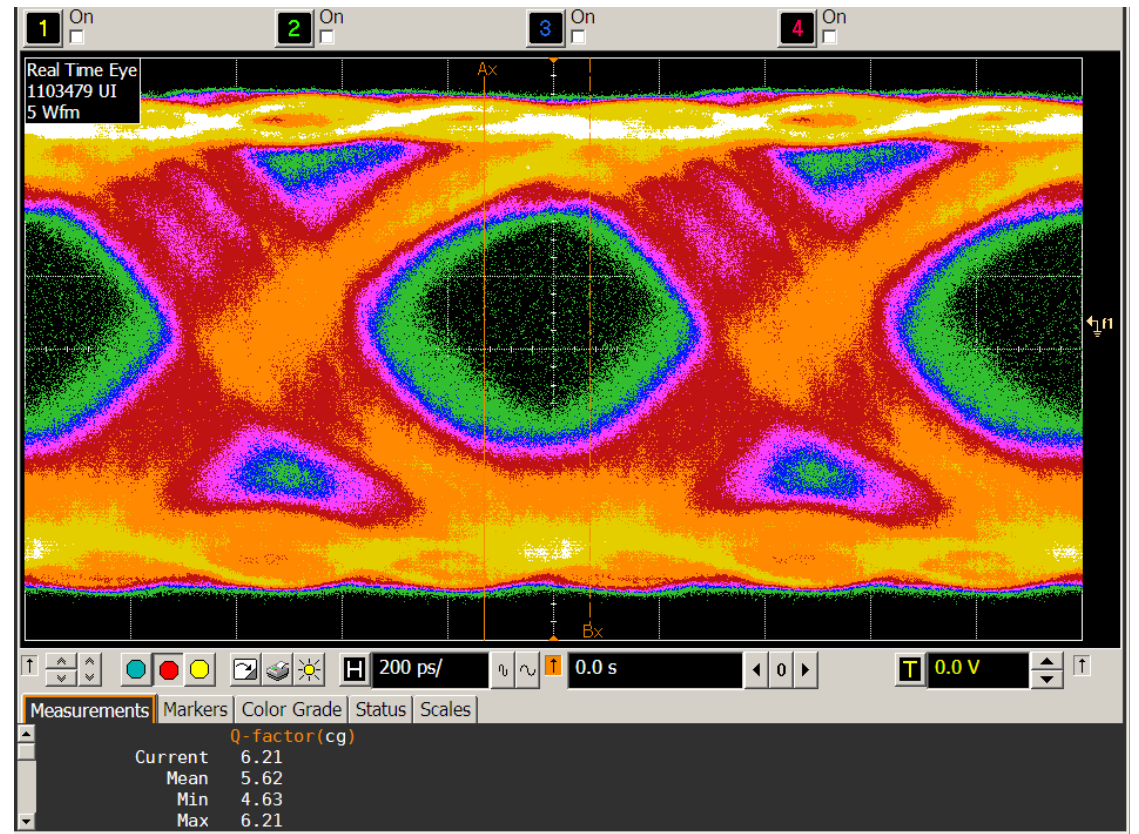
Figure 8. Eye diagram of received signal at 1